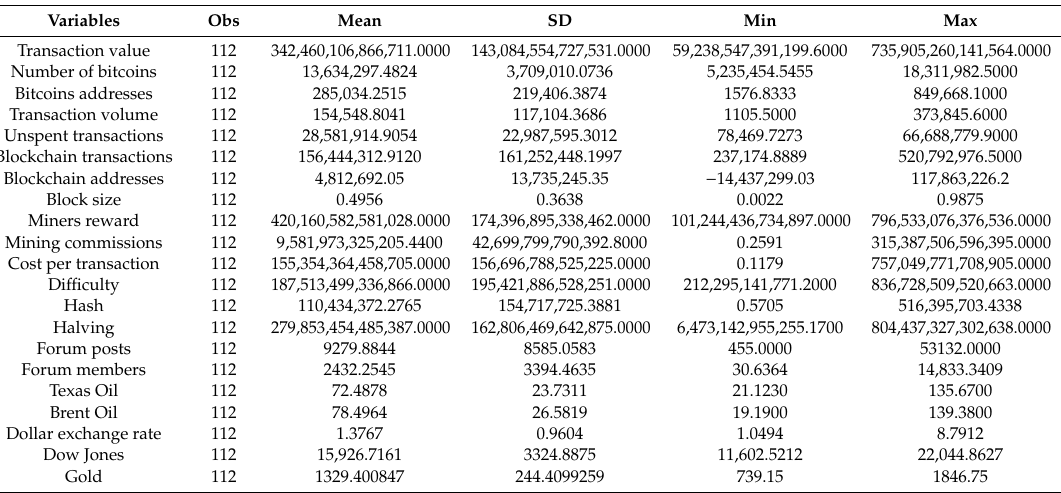
Table 2. Summary statistics.